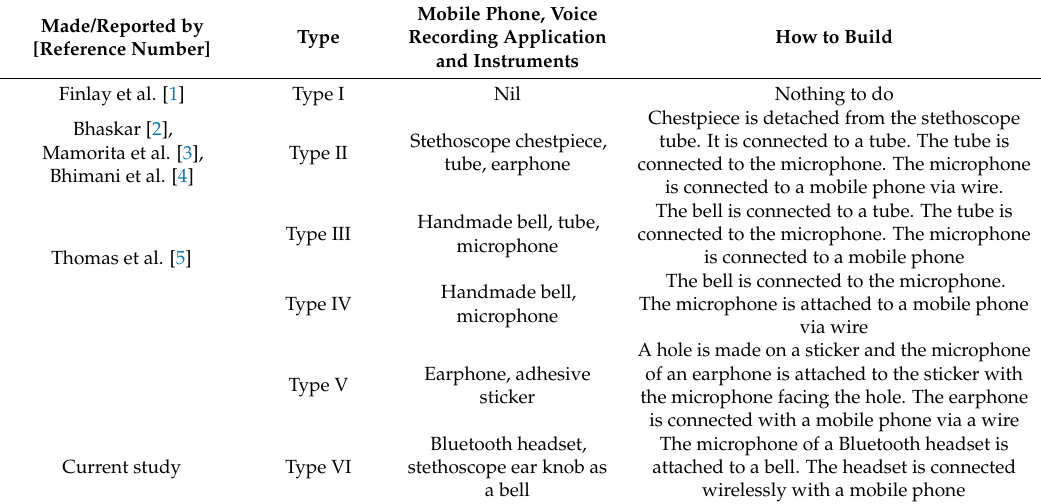
Table 1. Comparative list of different types of low-cost